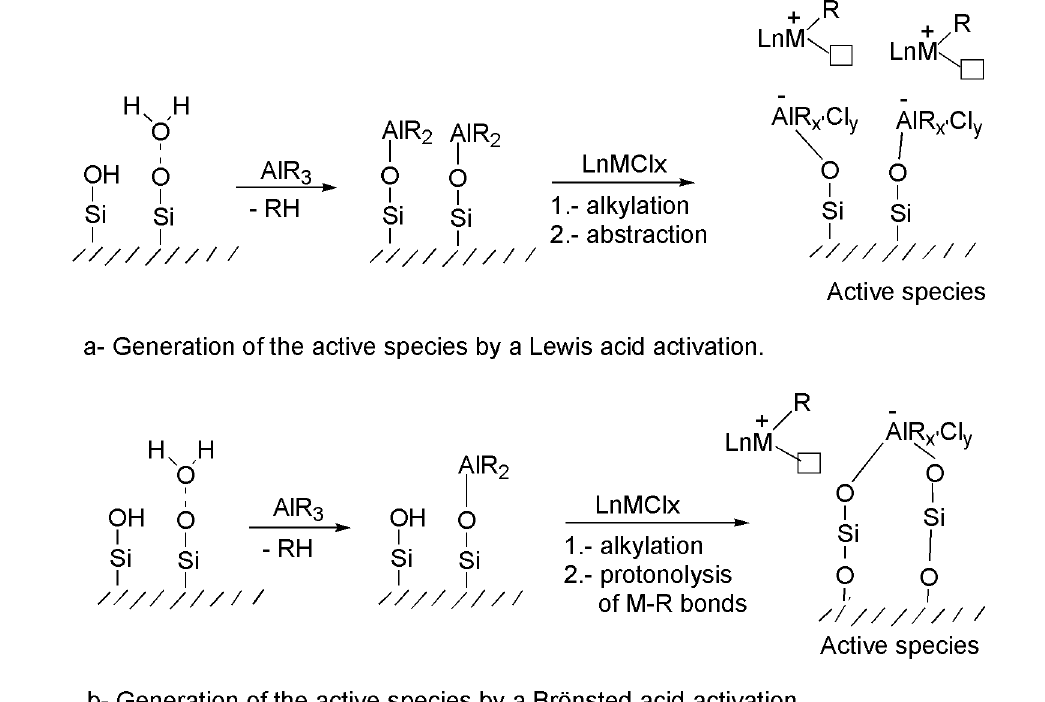
Scheme 1. Different activation pathways of precatalyst complexes considering the different nature of the acidic sites in the support